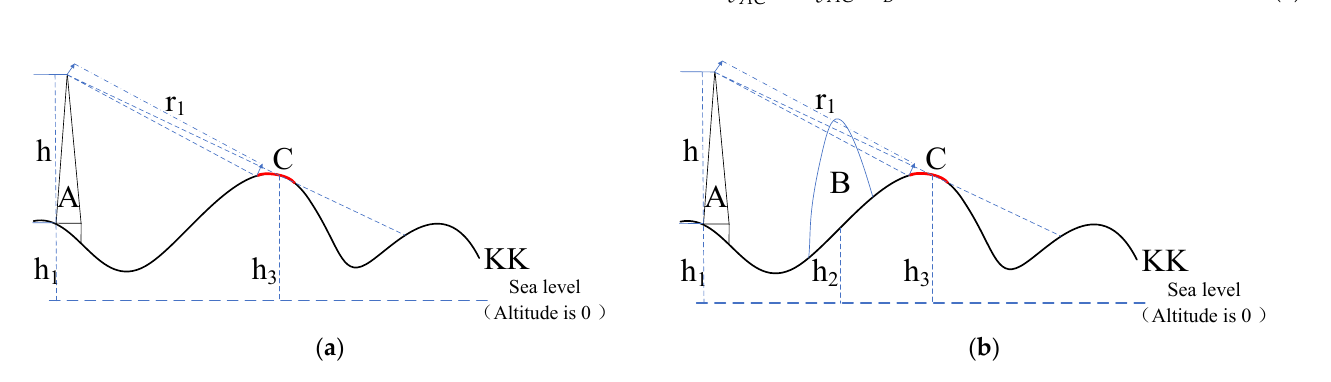
Figure 4. Environment occlusion in 2-D.